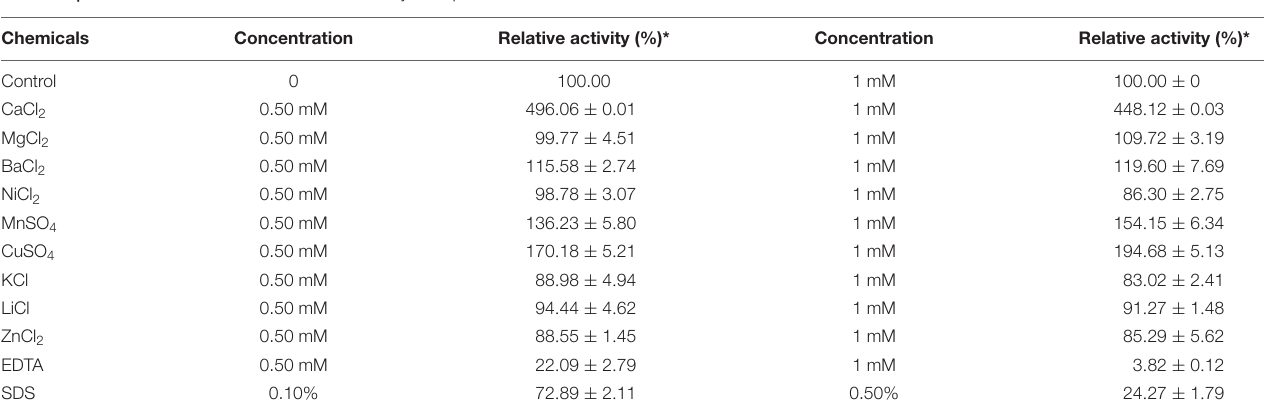
TABLE 2 | Effects of different chemicals on the activity of